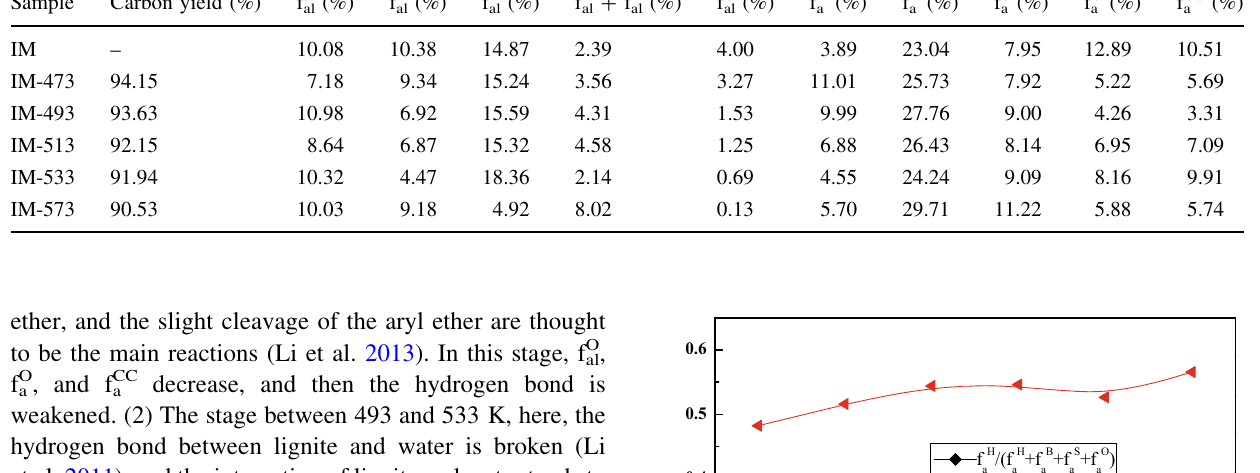
Table 2 Carbon structure distributions of the raw and treated IM on the basis of the raw lignite Sample Carbon yield (%)